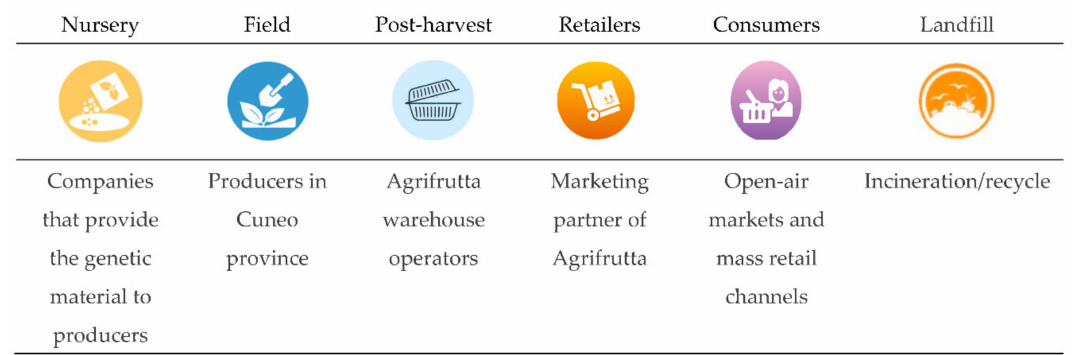
Figure 8. Raspberry supply chain framework. Reprinted from